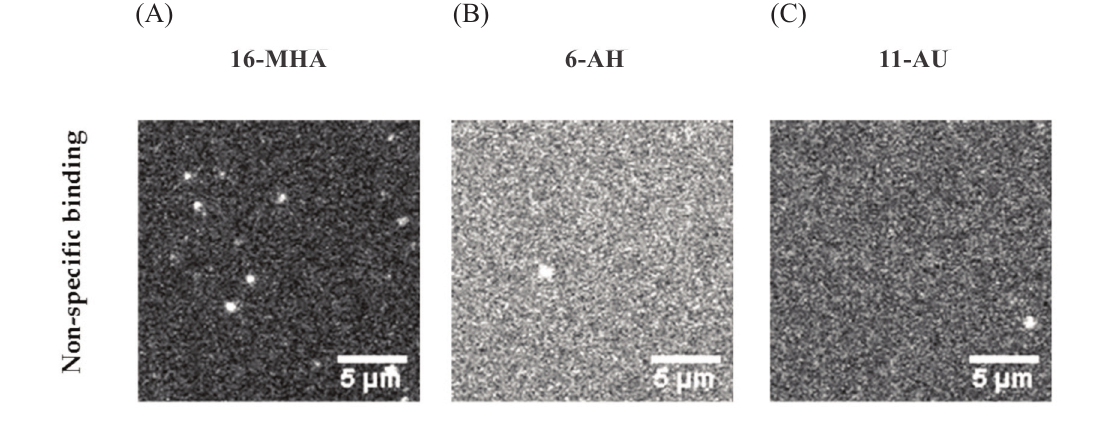
Fig. 5. TIRF images of non­specific binding of Alexa 488­labeled anti­rabbit antibody to electrodes with different SAM layers in the absence of the capturing antibody. The SAM layers were formed with 16­MHA (A), 6­AH (B) or 11­AU (C). The TIRF images were taken in the presence of 10 nM anti­rabbit antibody labeled with Alexa 488 and presented with increased contrast in the low­intensity range. The arbitrary intensity values were (0.5 ± 0.1) × 10 3 (A) ; (0.8 ± 0.2) × 10 3 (B) and (0.6 ± 0.1) × 10 3 (C) .